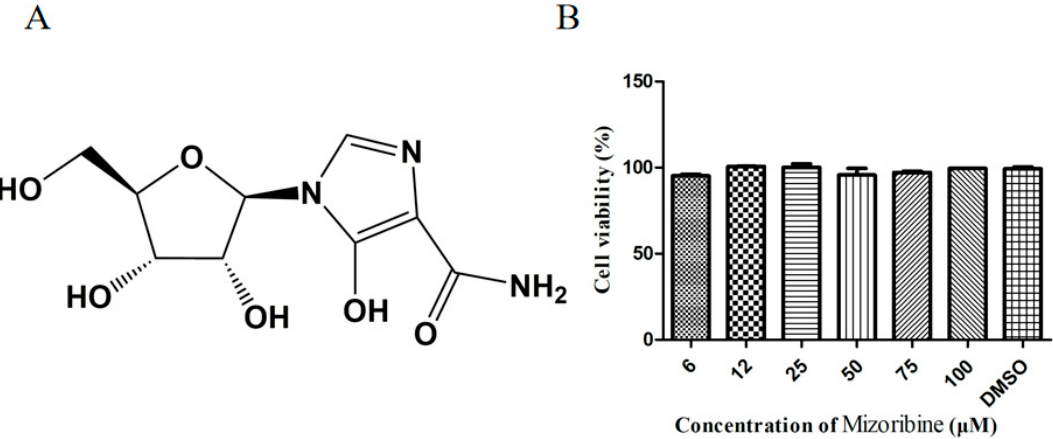
Figure 1. The cytotoxic effect of mizoribine treatment on IBRS-2 cells. ( A )The chemical structure of mizoribine. ( B ) The cytotoxic effect of mizoribine. The IBRS-2 cells were treated with 6, 12, 25, 50, 75, and 100 μ M mizoribine for 72 h. Relative cell viability was determined by MTS assay and normalized to the value of 1% DMSO-treated group (set at 100 %). Data are expressed as the mean ± SD of three independent experiments.